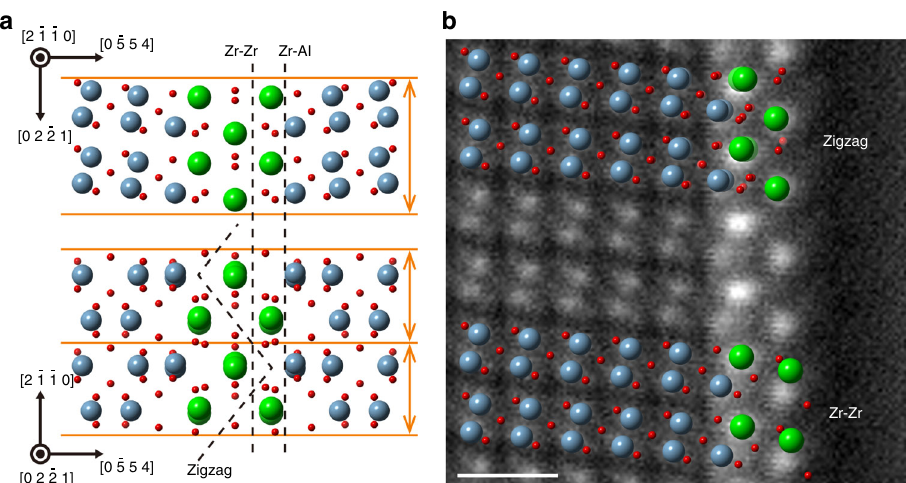
Fig. 3 Fracture path models for the cleavage energy calculations and averaged HAADF-STEM image of fracture surface with surface structural models after relaxation. a The grain boundary structures viewed from two orthogonal directions. The three fracture paths (dashed lines) were selected for the calculations. The orange horizontal lines represent the structural period of the initial grain boundary. b Averaged HAADF-STEM image from the Fig. 2a. The two relaxed surface structural models obtained by the calculation are superimposed on the image. The upper model is for the zigzag fracture model, and the lower is for the Zr – Zr straight fracture model. The zigzag fracture model agrees with the image better than the Zr – Zr straight fracture model. The scale bar is 0.5 nm